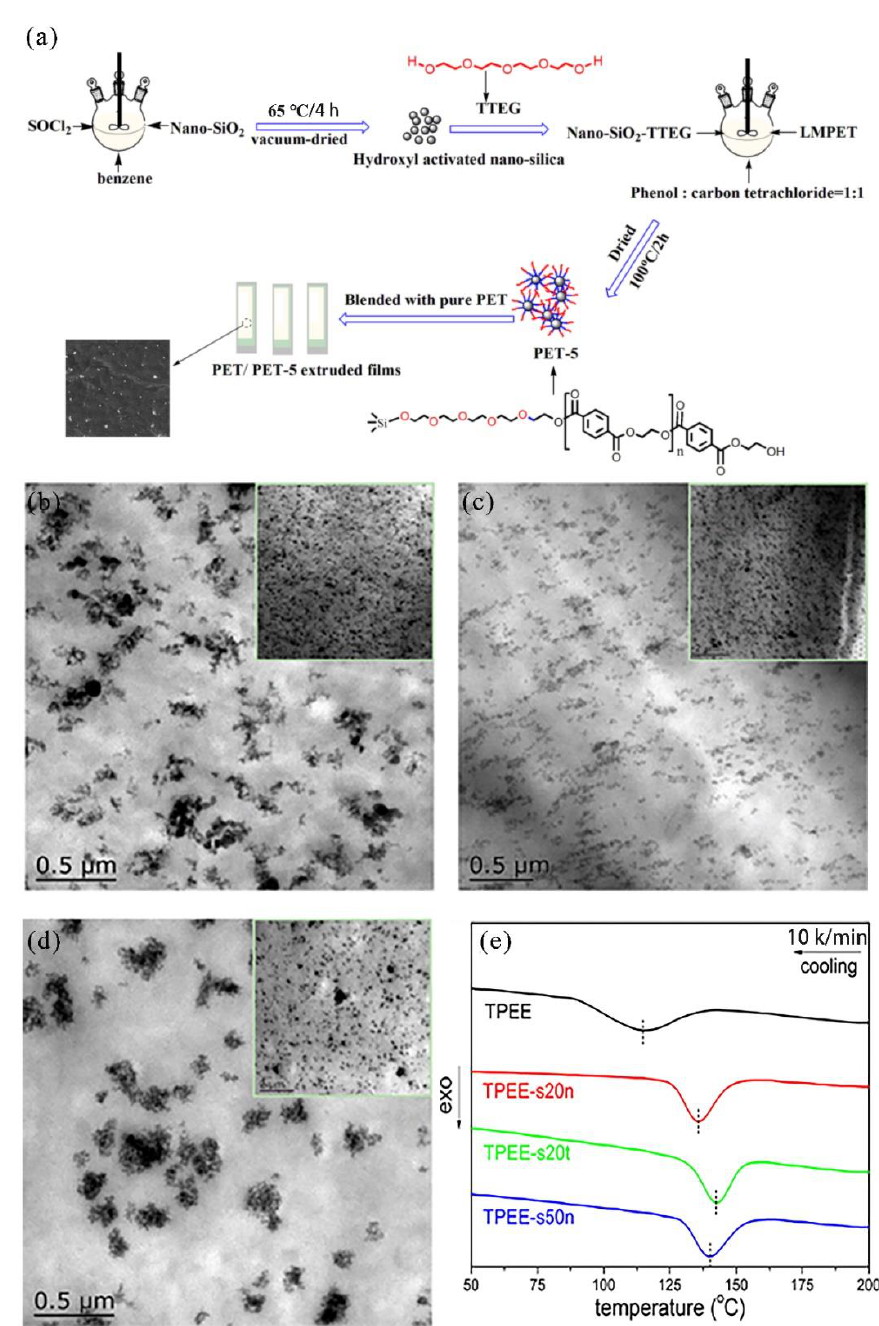
Figure 5. Investigation of the influence of SNs on the crystallization properties of polyester. ( a ) Scheme of interaction mechanism between PET and PET-5. Adapted with permission from [174]. Copyright 2018, MDPI. TEM images of ( b ) TPEE-s20n, ( c ) TPEE-s20t, and ( d ) TPEE-s50n. ( e ) DSC thermograms of neat TPEE and its nucleated samples obtained at a cooling rate of 10 ◦ C · min − 1 . Adapted with permission from [175]. Copyright 2016, American Chemical